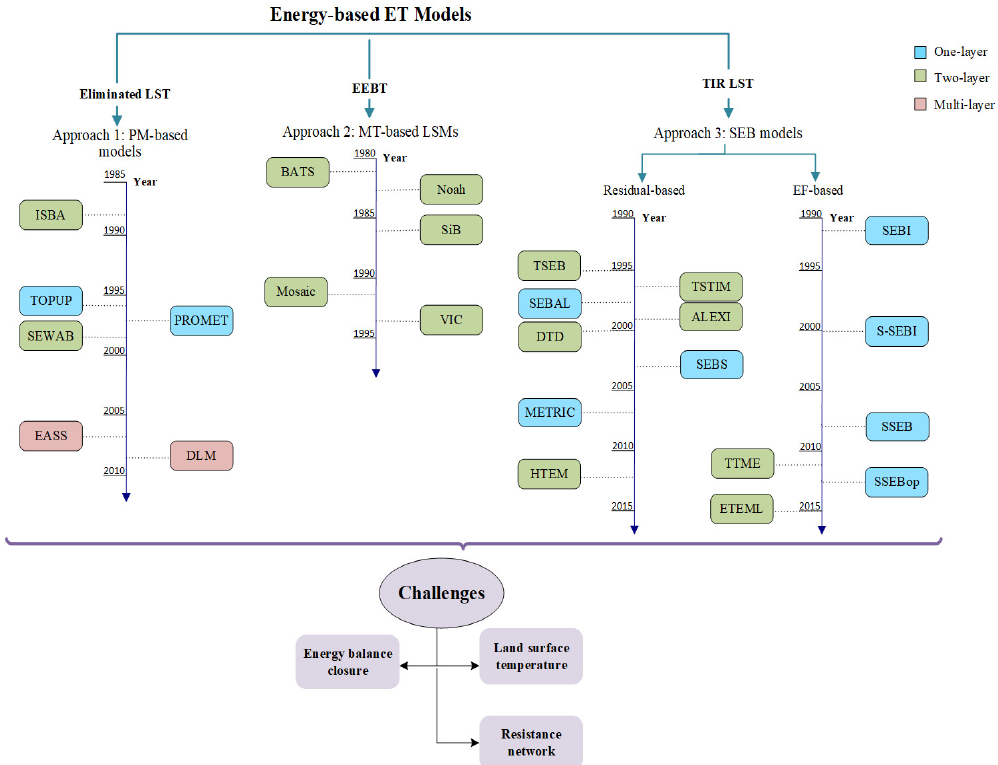
Figure 1. The flow diagram of the current